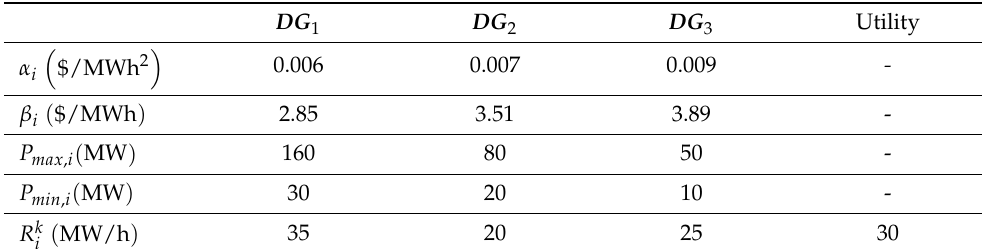
Table 2. Data of generators and